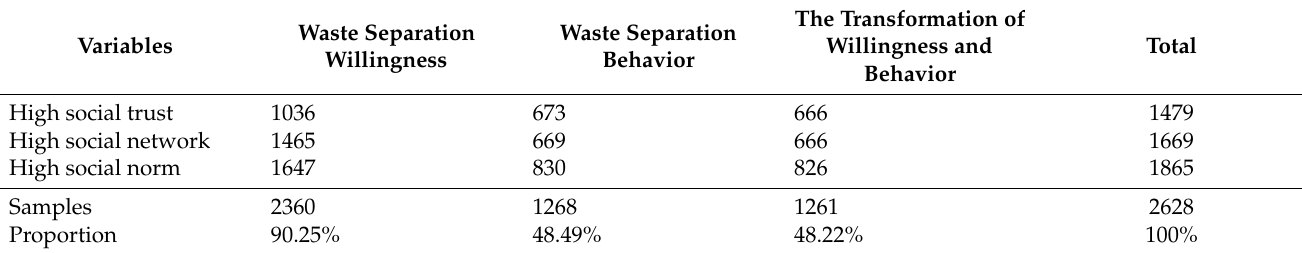
Table 2. Descriptive statistics of willingness and